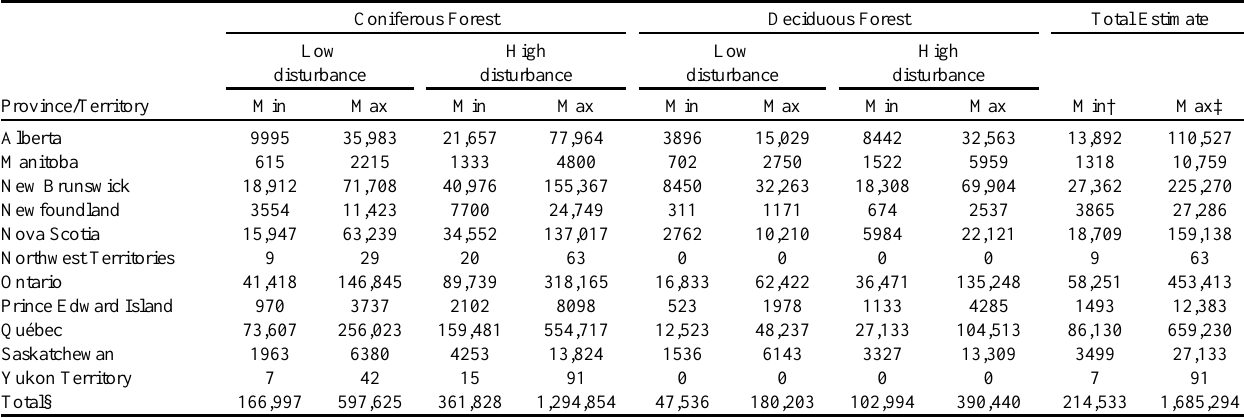
Table 4 . Estimated number of nests destroyed by forestry operations annually, derived by combination of avian nest densities, annual harvest area estimates, and proportion of the annual harvest presumed to occur during the migratory bird breeding season. Min and Max columns correspond to applying the low (MDD) versus high (EDR) density estimates, respectively, as per Table 1. The Low disturbance estimate assumes 12% of the annual area harvested (from Table 3) occurs during the breeding season following from FPAC (R. Décarie, unpublished manuscript ), and the High disturbance estimate assumes that 26% of the annual area disturbed (from Table 3) occurs during the breeding season, corresponds to the Ontario estimate provided by a submission to the Commission for Environmental Cooperation of North America (CEC